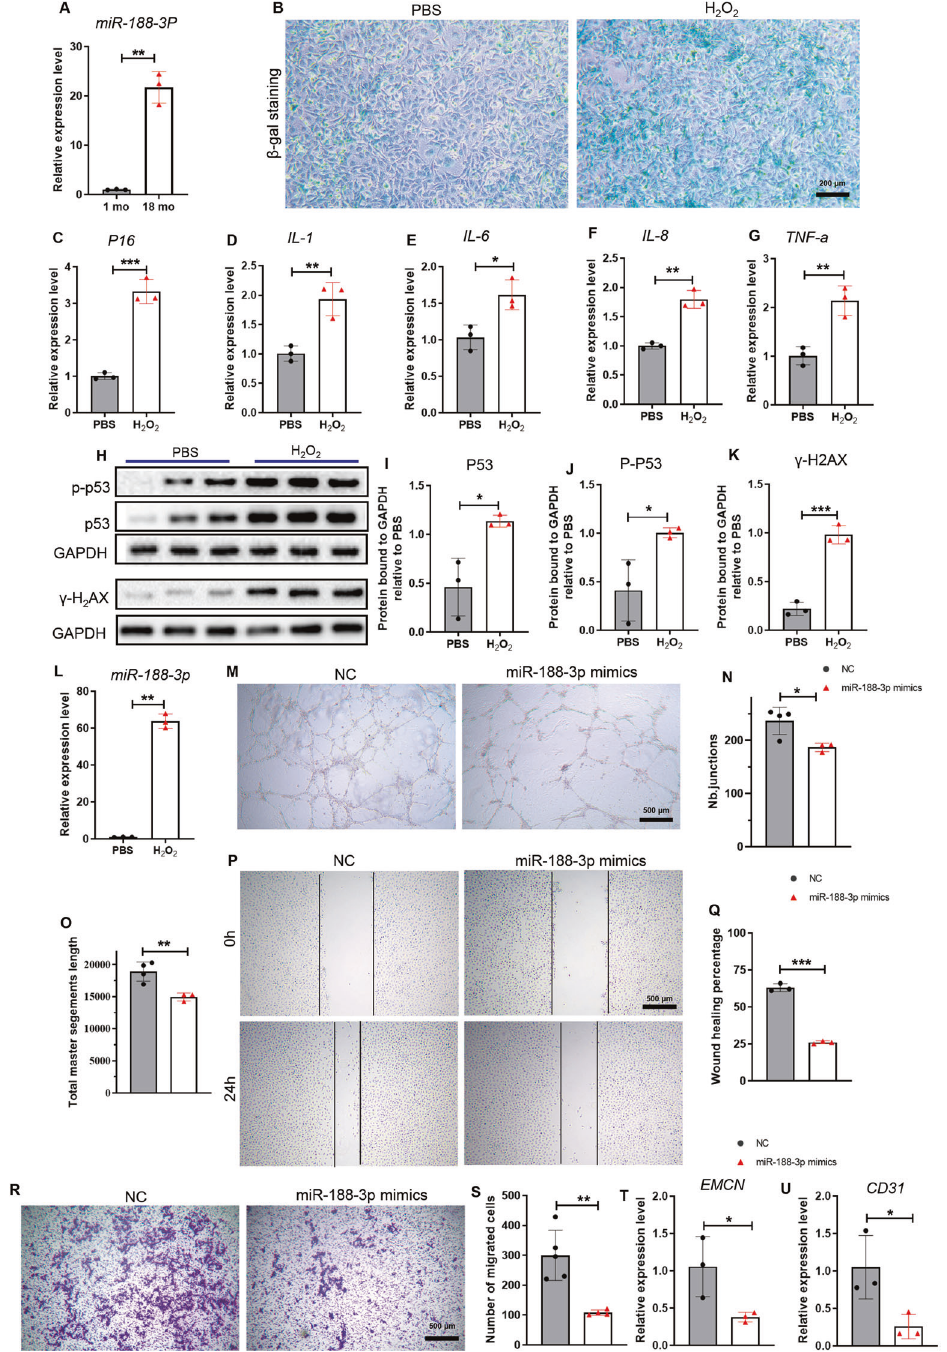
Fig. 2 miR-188-3p expression increased during senescence and inhibited angiogenesis in vitro. A The expression of miR-188-3p in primary endothelial progenitor cells from the age-indicated male C57BL/6 mice. n = 3 in each group. B Representative images of β -gal staining from HMEC-1 treated with PBS or H 2 O 2 . Scale bar = 200 µm. C – G The relative expression of Ink4a-p16 and SASP factors (IL-1, IL-6, IL-8, TNF-a) in the HMEC-1 cells treated with PBS or H 2 O 2 . n = 3 in each group. H – K Images of western blotting ( H ) and quantitative analysis of P53, P-P53, γ - H2AX protein expression levels ( I – K ) in the HMEC-1 cells treated with PBS or H 2 O 2 . n = 3 in each group. L The expression of miR-188-3p in HMEC-1 treated with PBS or H 2 O 2 . n = 3 in each group. M Representative images of tube formation assays from the groups transfected with miR-188-3p mimics or miRNA-NC. Scale bar = 500 μ m. N , O Quanti fi cation of tube junction numbers ( N ) and total master segment length ( O ) in the tube formation assays of the indicated groups. n = 3 miR-188-3p mimic-treated groups, n = 4 miRNA-NC-treated groups. P , Q Representative images ( P ) and wound healing percentage ( Q ) of the endothelial cell line transfected with miR-188-3p or miRNA-NC in the wound healing assays. Scale bar = 500 μ m. n = 3 in each group. R , S Representative images ( R ) and quantitative analysis ( S ) of the migrated cells from a Transwell migration assay. Scale bar = 500 μ m. n = 4 miR-188-3p-treated group, n = 5 miRNA-NC-treated group. T , U The relative expression of Emcn ( T ) and CD31 ( U ) in the HMEC-1 cells transfected with miR-188-3p mimics or miRNA-NC. n = 3 in each group. NC: treated with miRNA-NC, miR-188-3p mimics: treated with miR-188-3p mimics. Data are shown as the mean ± SD. n.s. no signi fi cance; * P < 0.05; ** P < 0.01; *** P < 0.001 by two-tailed Student ’ s t test or Welch ’ s t t